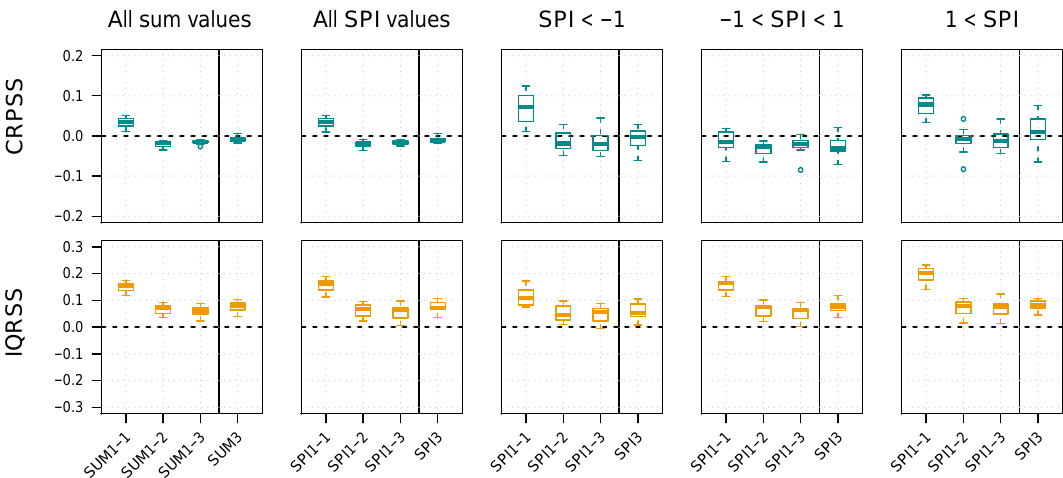
Figure 2. CRPSS and IQRSS of SPI forecasts and forecasts of cumulative precipitation produced from bias corrected System 4 precipitation forecasts. The reference for the skill scores is climatology. Skill scores are presented for statistics calculated for each month of the 3-month lead time (SUM1 and SPI1) and over the 3 months altogether (SUM3 and SPI3). Columns correspond to scores computed for sums, SPI values, SPI values smaller than − 1 (dry), SPI values within − 1 and 1 (normal) and SPI values greater than 1 (wet).